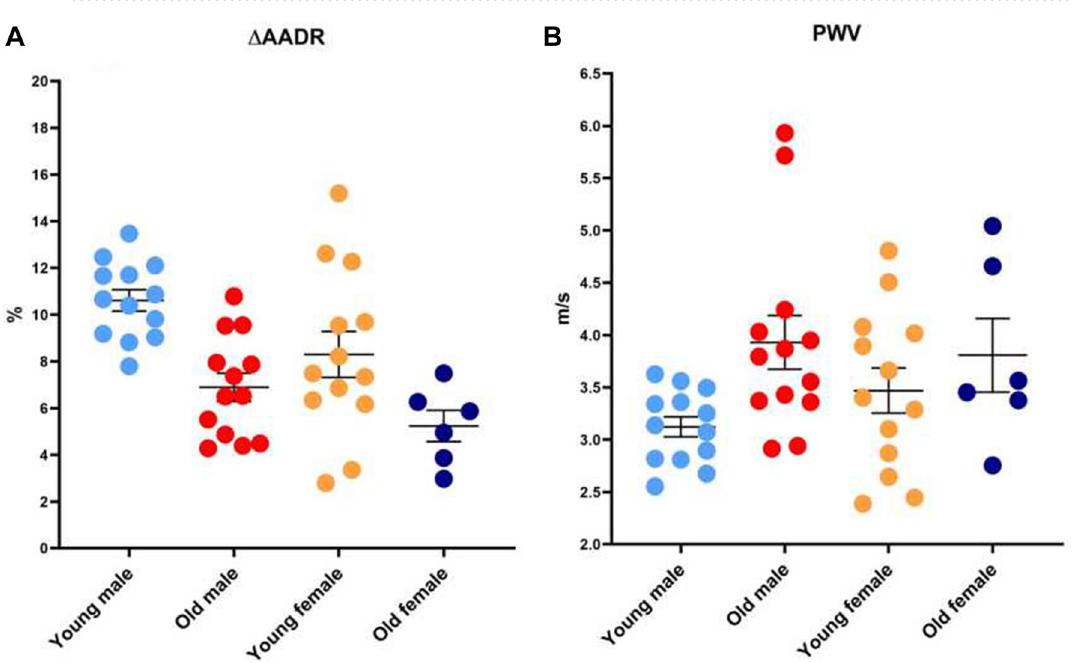
Figure 8. Vascular SF parameters. ( A ) Comparison of ∆AADR between old and young groups. ( B ) Comparison of PWV between old and young